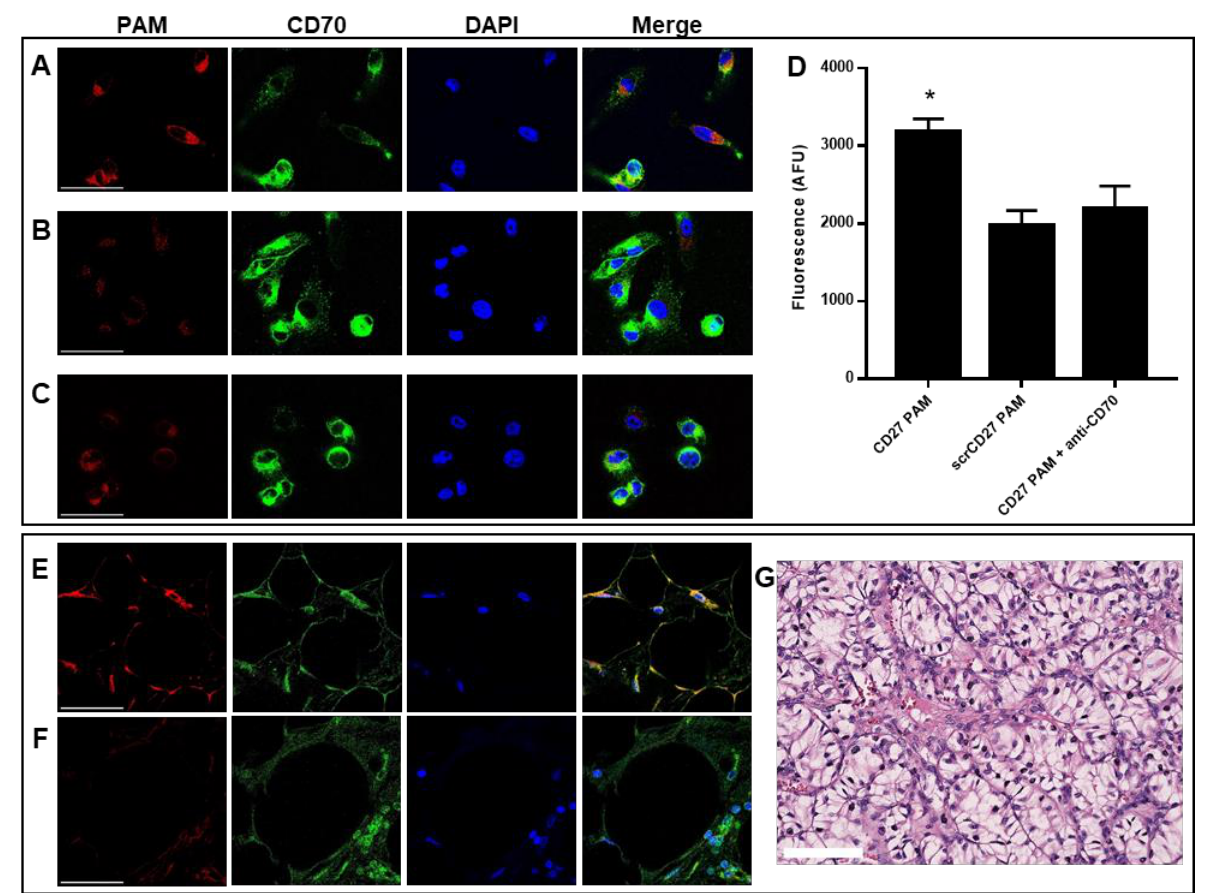
Figure 3. In vitro binding to patient-derived ccRCC cells and to tumor tissue sections. Confocal microscopy images of patient-derived ccRCC cells that were immunostained for CD70 (green), counterstained with DAPI (blue), and incubated for 30 min with 50 μM FITC -labeled micelles (red). ( A ) CD27 PAMs have increased binding to ccRCC cells in vitro compared to ( B ) scrCD27 PAMs. ( C ) CD27 PAM binding is reduced after pre-incubation with anti-CD70 antibodies, confirming specificity of CD27 PAMs for CD70. ( D ) CD27 PAMs have significantly increased binding compared to scrCD27 PAMs, but not if target cells are pre-treated with anti-CD70. N = 6. * p < 0.05. ( E ) ccRCC tumor tissue sections incubated for 1 h with 10 μM CD27 micelles have increased nanoparticle signal compared to ( F ) scrCD27 micelles. Scale bar = 50 μm. ( G ) Representative H&E-stained ccRCC tumor tissue section. Scale bar = 100 μm.